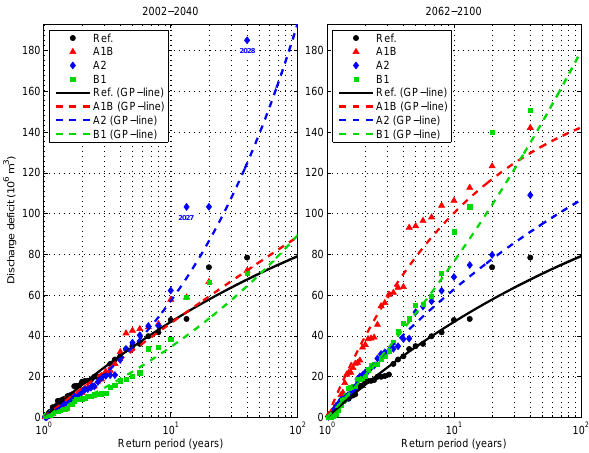
Fig. 8. Annual maximum cumulative deficit of streamflow with respect to the 75th percentile of the reference period versus its return period for the reference period and the climate scenarios, shown for the period 2002–2040 (left) and the period 2062–2100 (right). Corresponding Generalized Pareto (GP) distributions are fitted to the data.